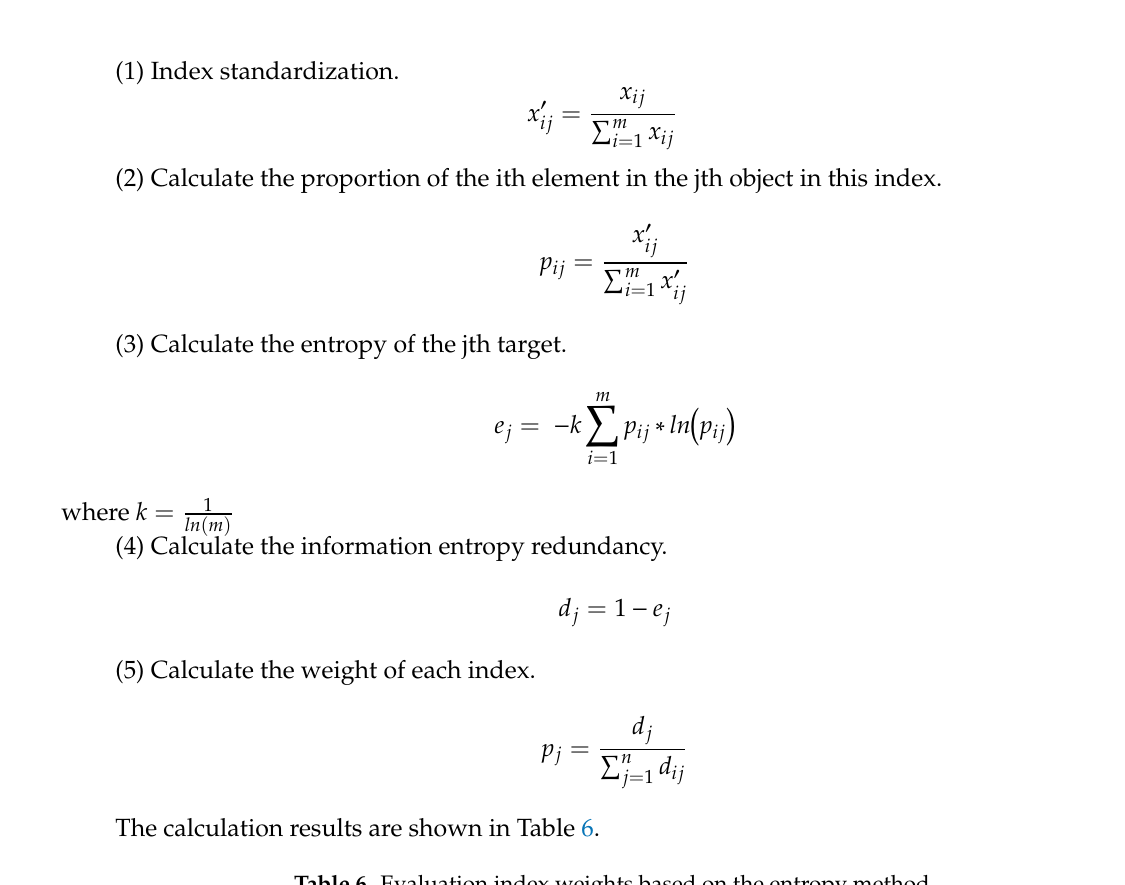
Table 6. Evaluation index weights based on the entropy